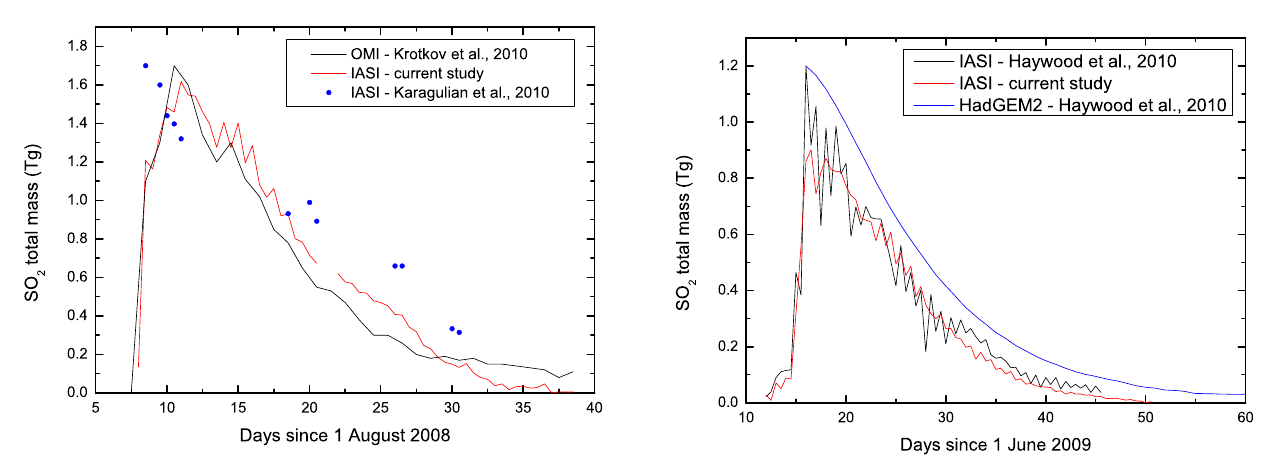
Fig. 11. Time series of SO 2 measured with IASI: original study (Haywood et al., 2010) in black, current reanalysis in red and HadGEM2 model in